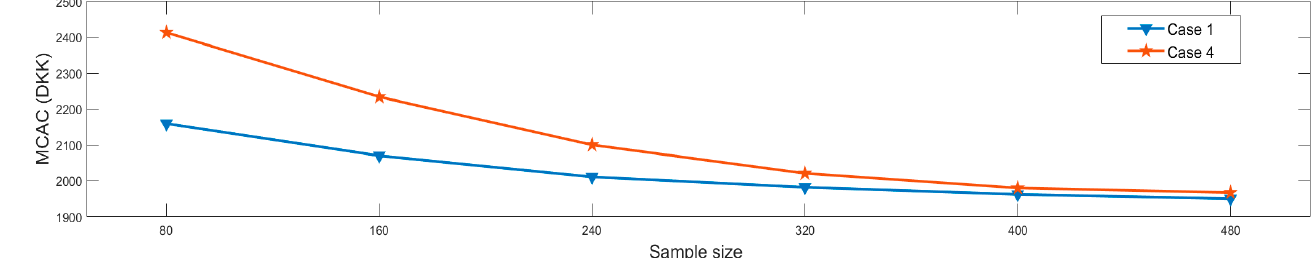
Figure 8. The MCAC of Case 1 and Case 4 with different sample sizes.